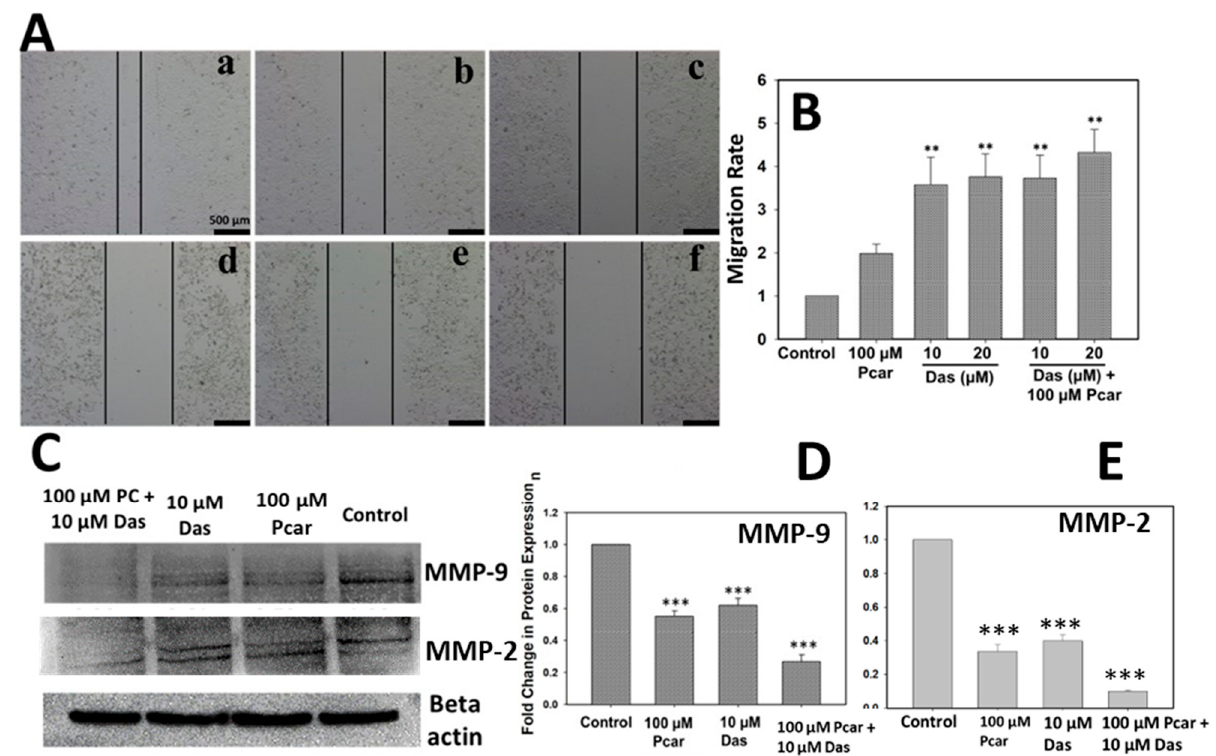
Figure 2. Pcar and Das combined therapy inhibited the migration of cancerous cells. ( A ) Microscopic images showing the wound healing assay revealed that Pcar and Das in combination efficiently suppress the migration rate of cancerous cells. ( B ) Quantitative analysis of migration assay was obtained by measuring 3 independent microscopic areas. ( C ) Analysis of MMP-9 and MMP-2 protein expression. ( a ) Control; ( b ) 100 µM Pcar; ( c , d ) 10 and 20 µM Das; ( e , f ) 100 µM Pcar + 10 and 20 µM Das. Quantitative estimation of ( D ) MMP-9 and ( E ) MMP-2 protein expression in control and treated cells. Data expressed as mean ± standard error (SE) calculated from three ( n = 3) independent experiments, ** p < 0.01, *** p < 0.001. Scale bar 500 µm.